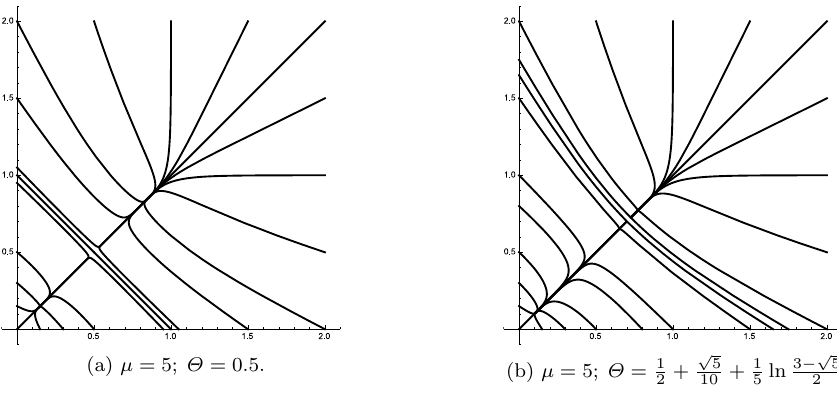
Figure 8. The phase portraits with different parameters.